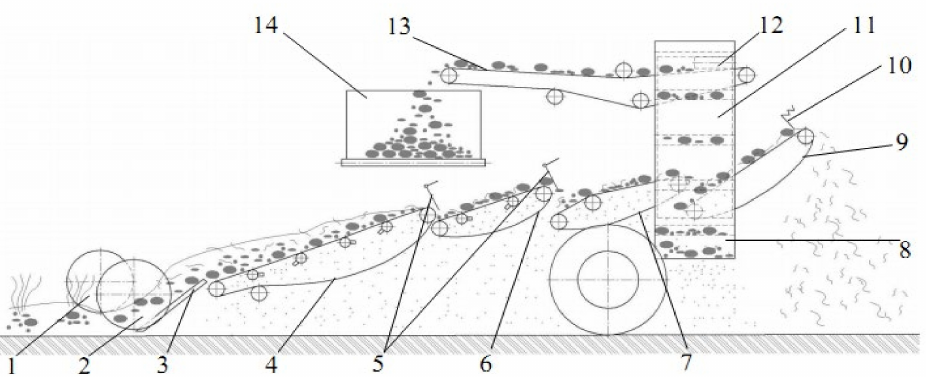
Figure 14. Technological scheme of the combine “Dewulf RA-3060”: 1—rollers; 2—vertical disks; 3—plowshare; 4—main elevator; 5—defoliators; 6—cascade elevator; 7—additional ele- vator; 8—bucket elevator; 9—finger slide; 10—baffle element; 11—supporting tape; 12—shaft; 13—bulkhead table;